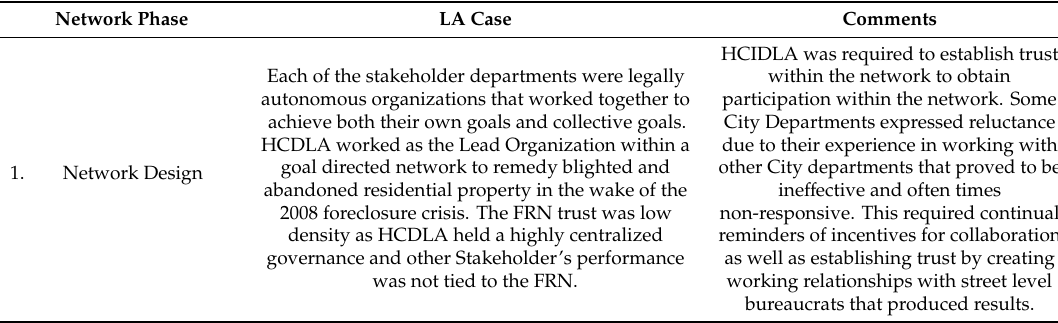
Table 2. Phases of Network Building and Case